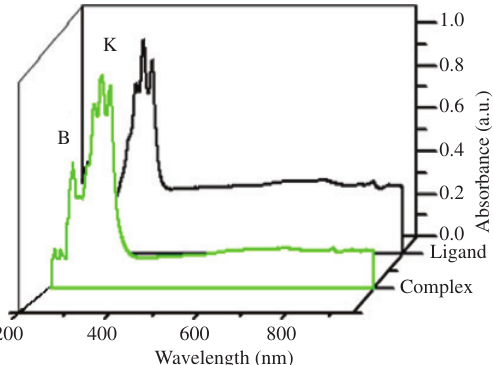
Figure 4: The absorption spectra of complex 1 and free HL